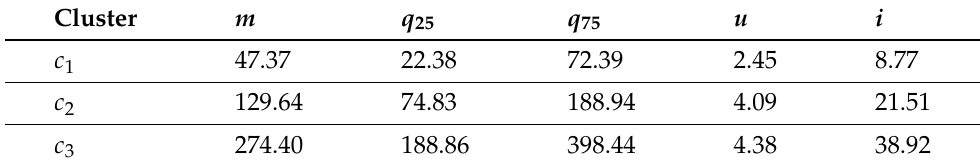
Table 3. Values of the descriptive features for the three clusters extracted from the